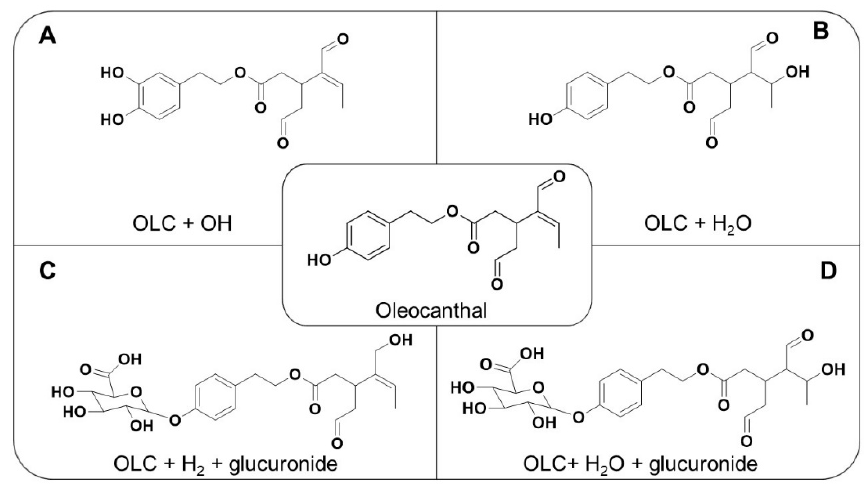
Figure 1. Chemical structure of oleocanthal and metabolites ( A ) = hydroxylated OLC; ( B ) = hydrated OLC; ( C ) = hydrogenated glucuronide; ( D ) = hydrated glucuronide).